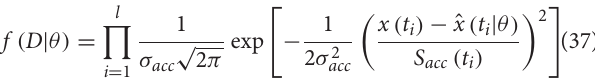
associated with BWBN hysteresis model for different cases. The mass coefficient of each floor is 1 kg, stiffness coefficient 10 N/m (sin) and 20 N/m (ElCentro), damping coefficient 0.05 N/(m/s) for each floor, respectively.